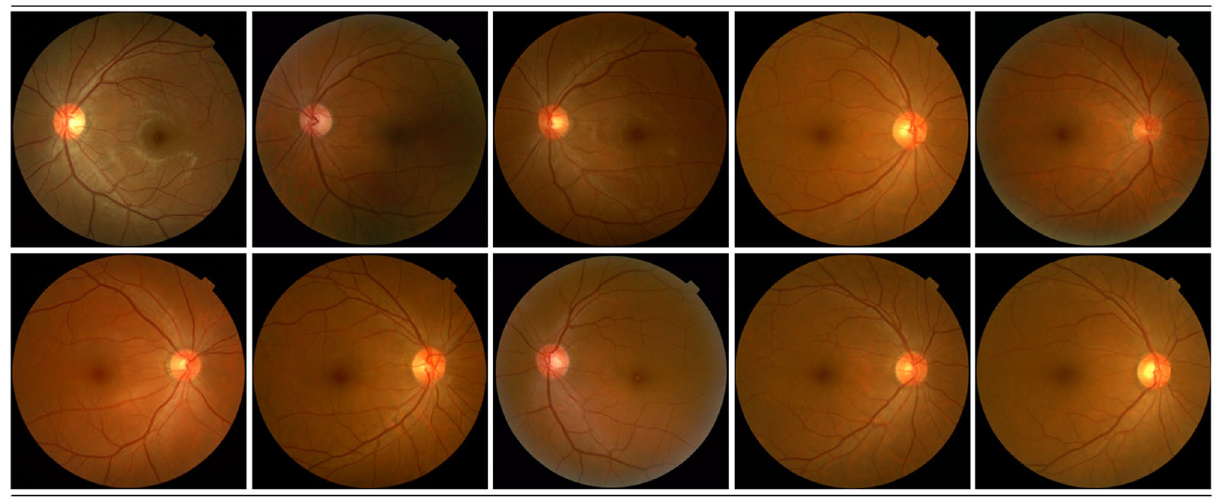
Figure 1. Examples of randomly synthesized